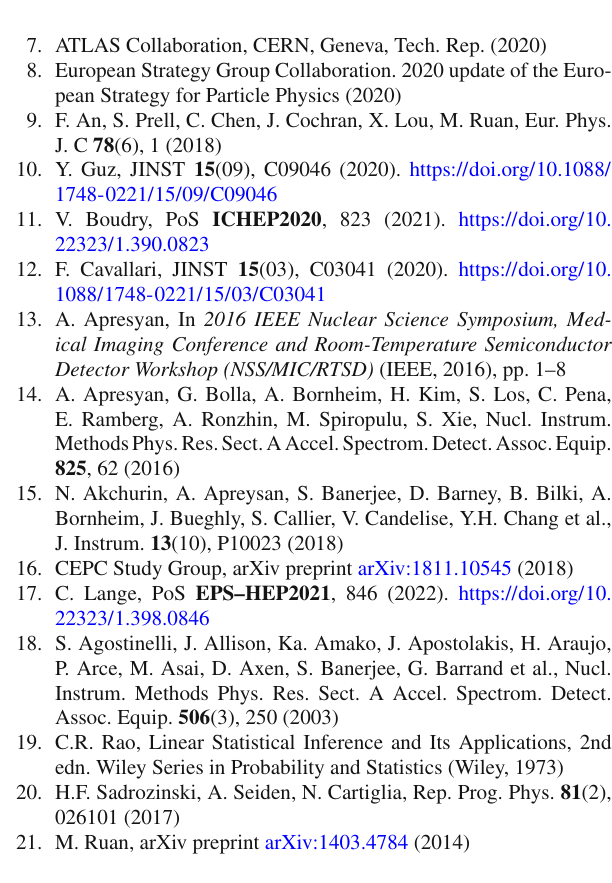
Fig. 18 The shower timing bias(top) and resolution(bottom) from quantile-based algorithm and average-based algorithms with energy weights of , n = 0 , 1 / 2 , 1 , 2 , 3 , 4 as a function of E n hit